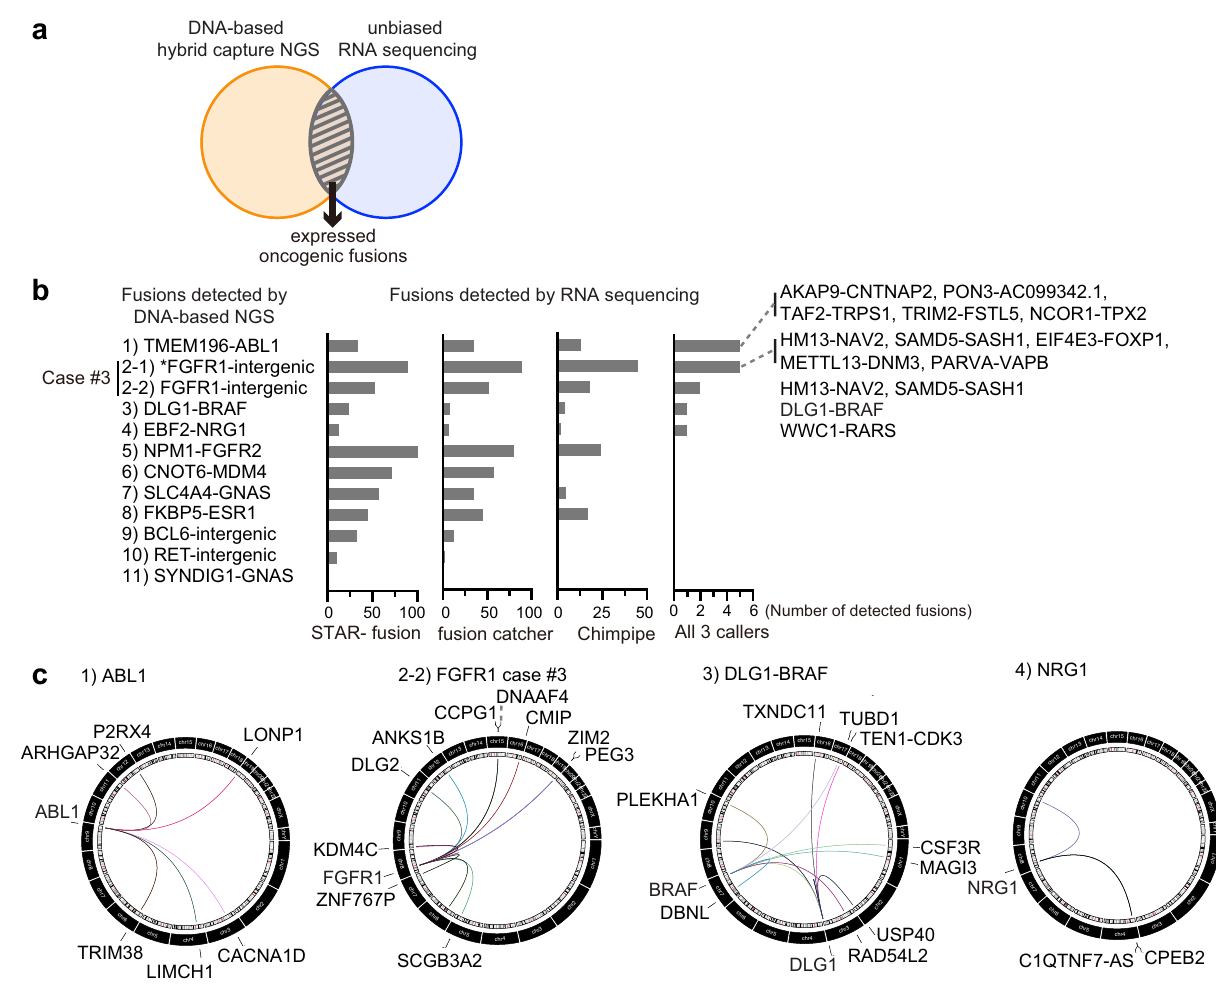
Fig. 4 | Comparison of putative fusions by DNA-seq and RNA-seq. a Schema of integrating data obtained by DNA-based next generation sequencing (NGS) OncoPanel, and RNA-sequencing (RNA-seq), to pick out expressed oncogenic fusions. b The candidate fusions detected by eachfusion caller from RNA-seq data were aligned with putative oncogenic fusions detected by OncoPanel. Fusions